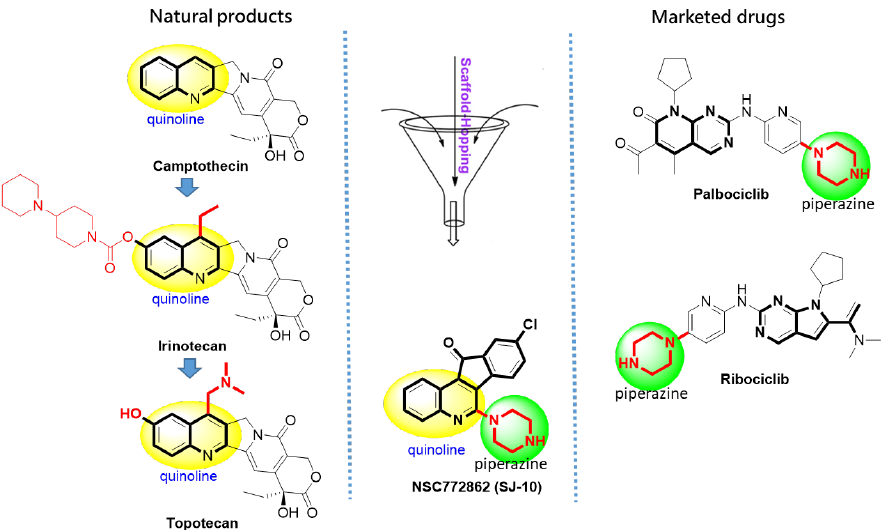
Figure 1. Rationale of NSC772862 (SJ10) and some of the representative drugs in natural products and marketed drugs.